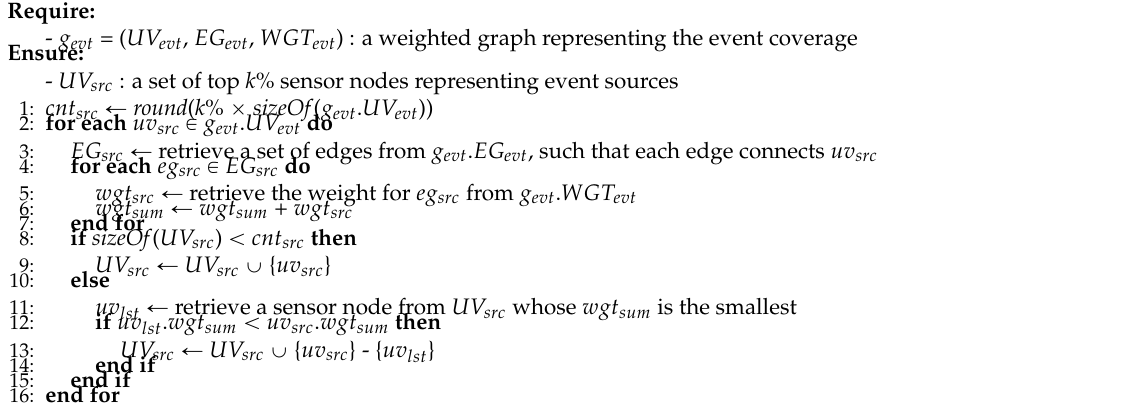
Algorithm 5 Event source